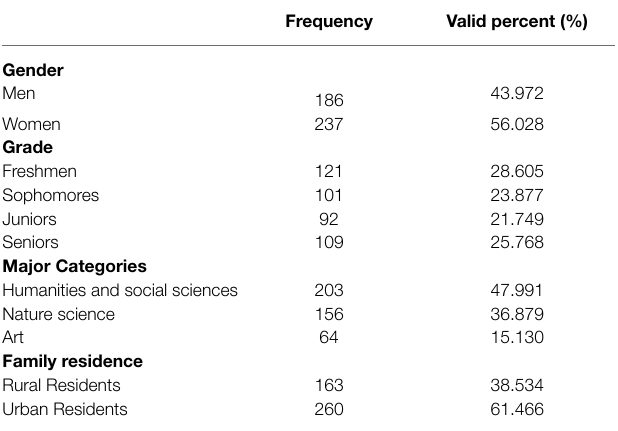
TABLE 1 | Sample characteristics, descriptive, and